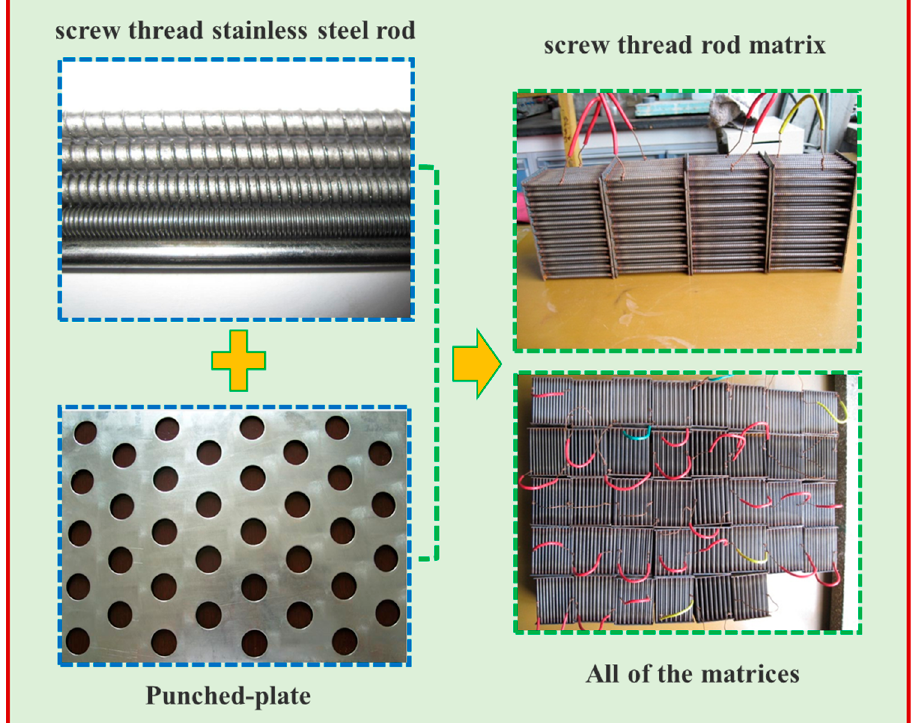
Figure 1. The screw thread rod matrix.